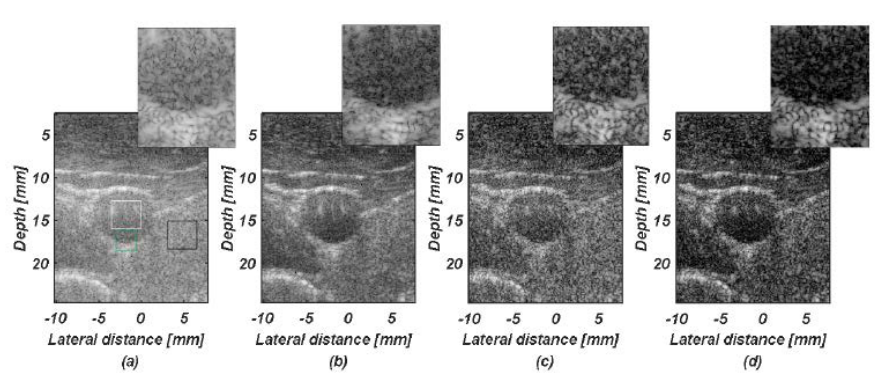
Figure 7. In vivo images of different methods. ( a ) DAS, ( b ) sSCF, ( c ) aSCF, ( d ) uSCF. All images are shown in a 70 dB dynamic range. Each image is shown with a magnified view of the region enclosed by the green square (shown in the upper-right corner).